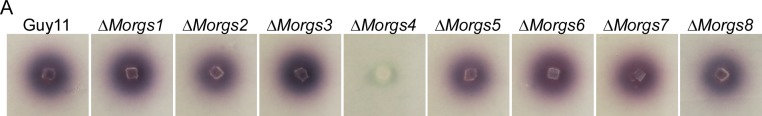
MoRgs4 has a role in the regulation of extracellular laccase activities.(A) Laccase activity was tested on CM agar medium containing 0.2 mM ABTS at final concentration. Discoloration was observed on day 2 after inoculation.